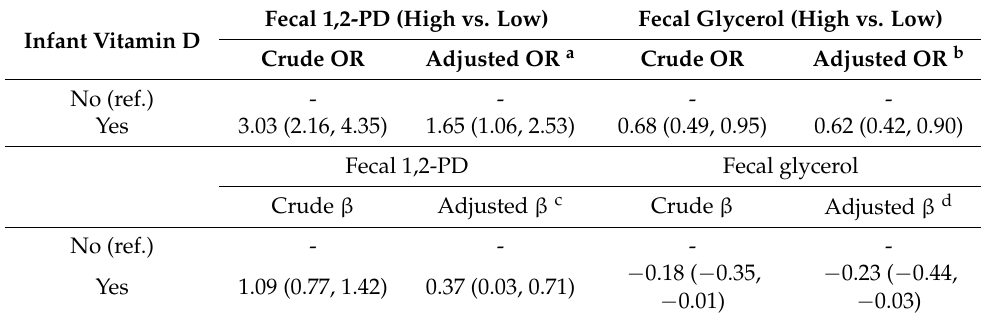
Table 2. Regression results for prediction of fecal 1,2-PD, glycerol levels from infant use of vitamin D drops. Fecal 1,2-PD (High vs. Low) Fecal Glycerol (High vs. Low) Infant Vitamin D Crude OR Adjusted OR a Crude OR No (ref.)